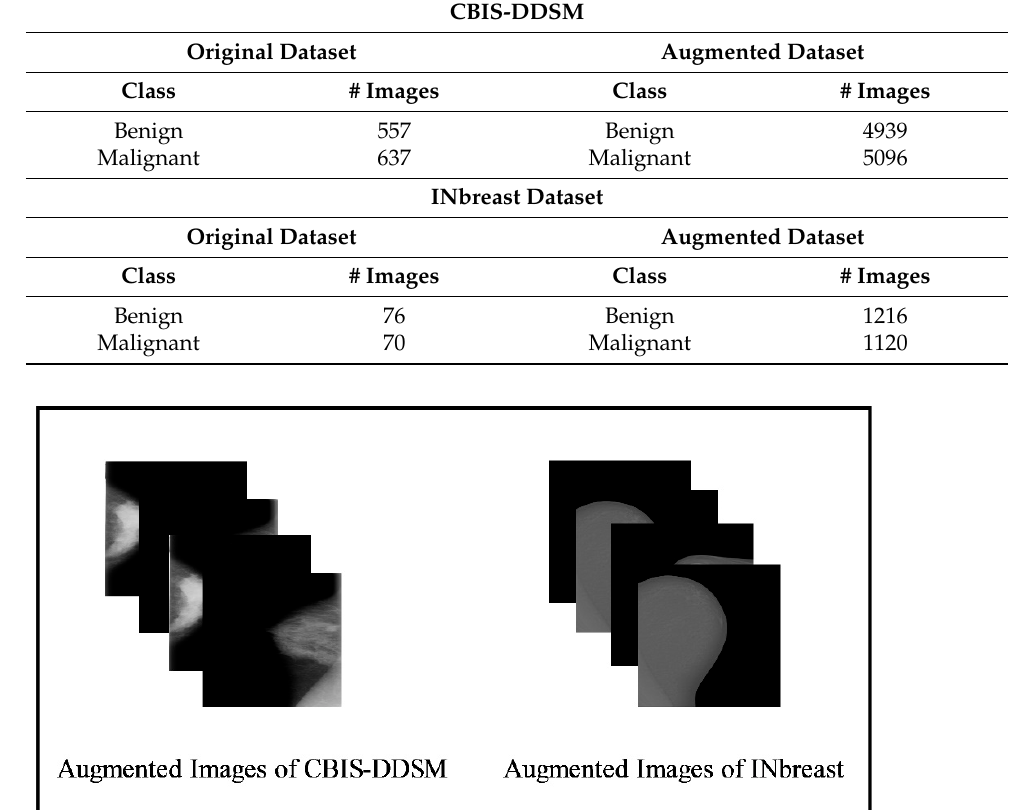
Figure 5. Visual illustration of data augmentation step.